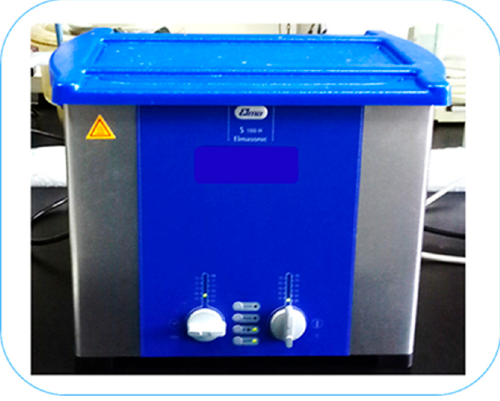
Figure 9. The ultrasonication instrument for the extraction of the original DCLR.